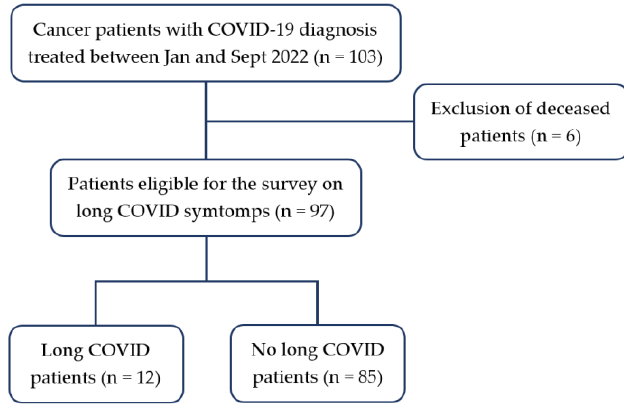
Figure 1. Flowchart.